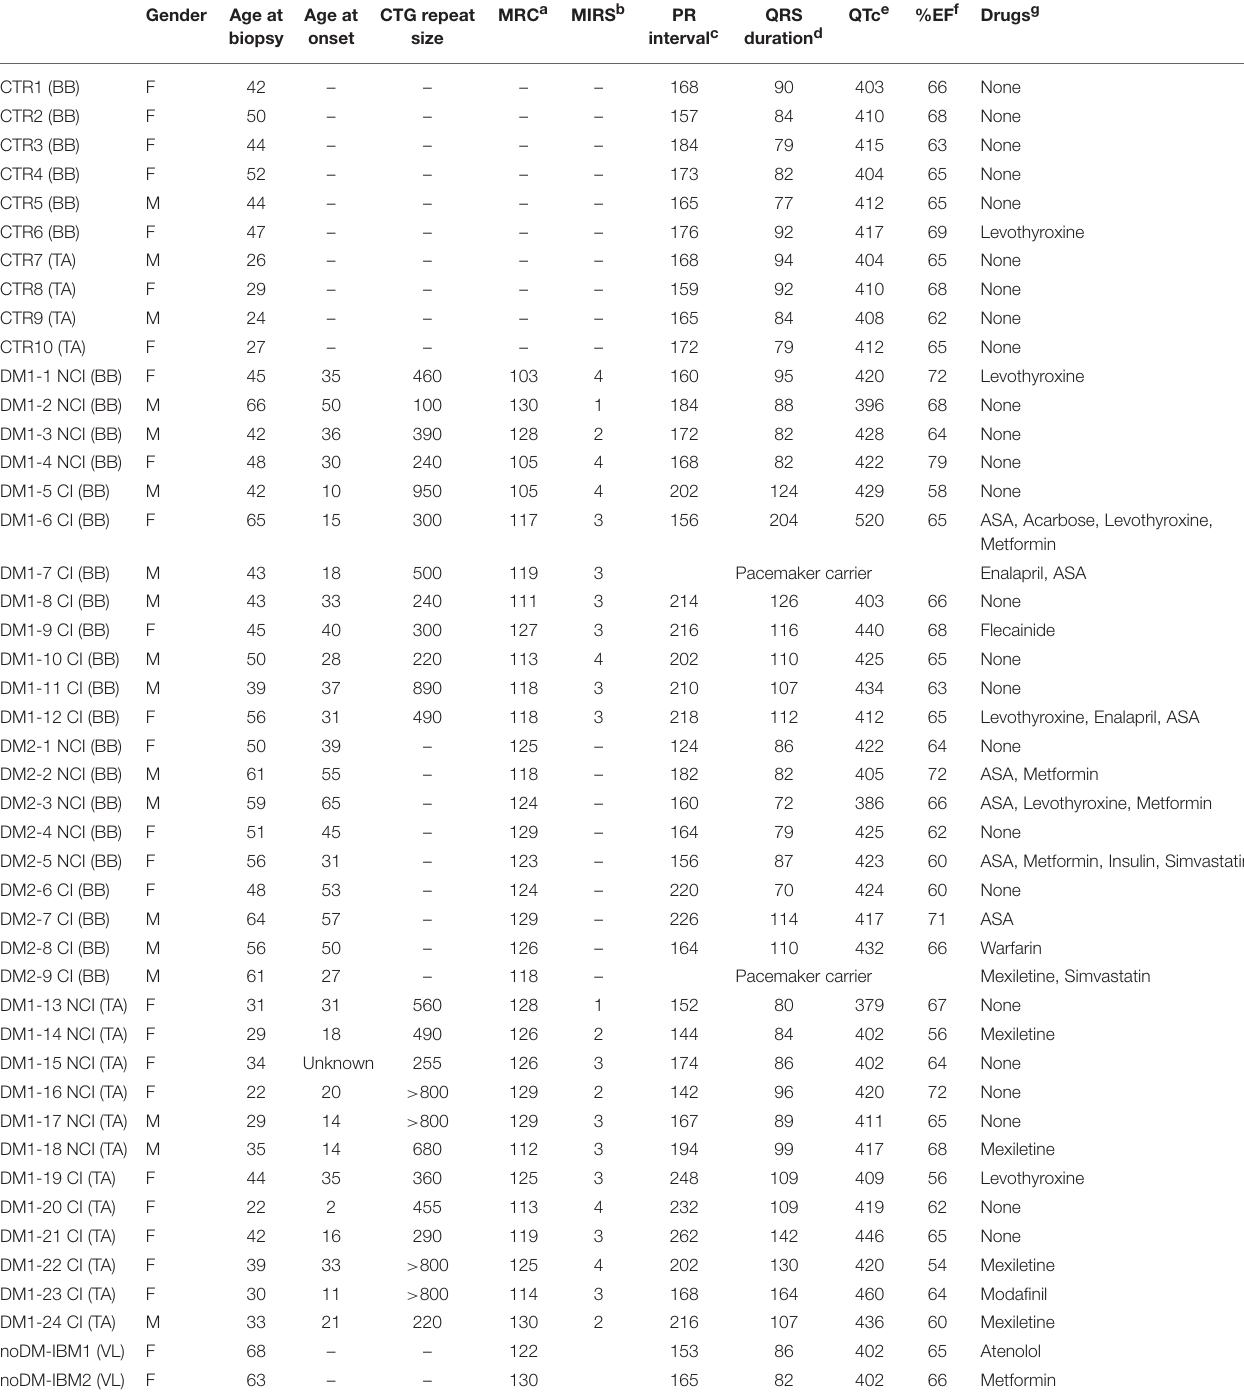
TABLE 2 | Clinical data on control, DM1, and DM2 patients. Gender Age at Age at biopsy